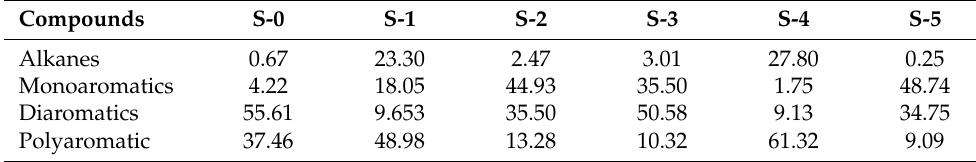
Table 2. Composition and content of aromatic fractions of heavy oil and upgraded oil samples. Compounds